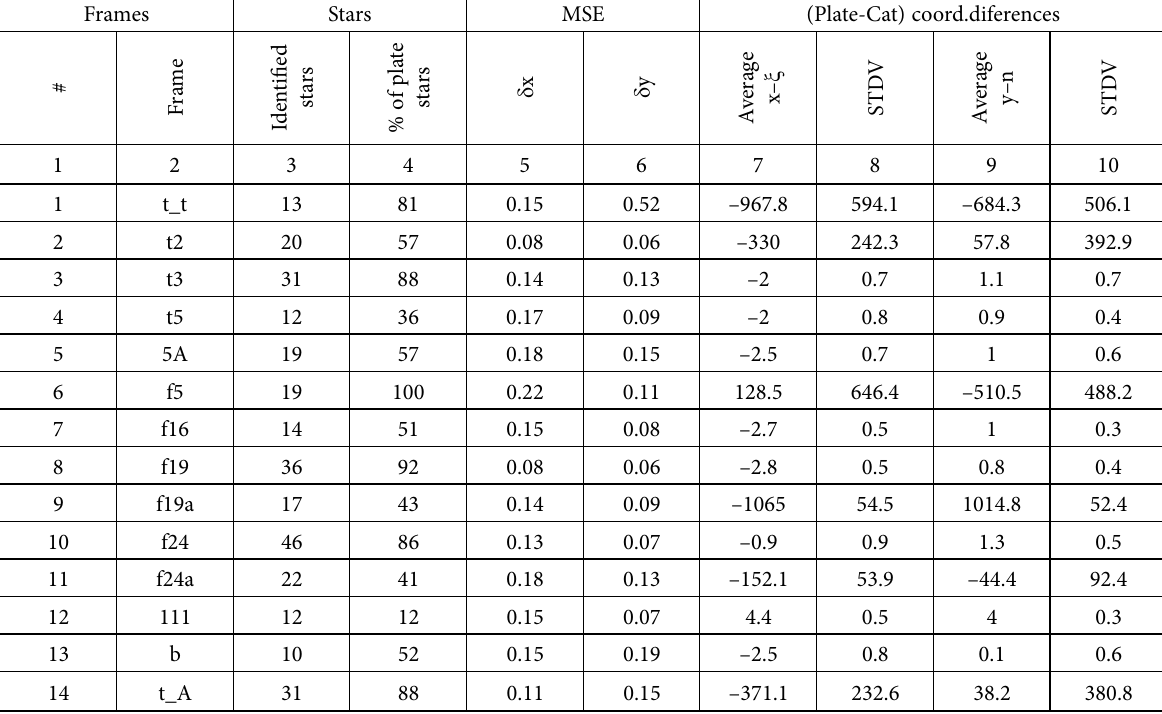
Table 1. Disposition of the plate and catalogue star